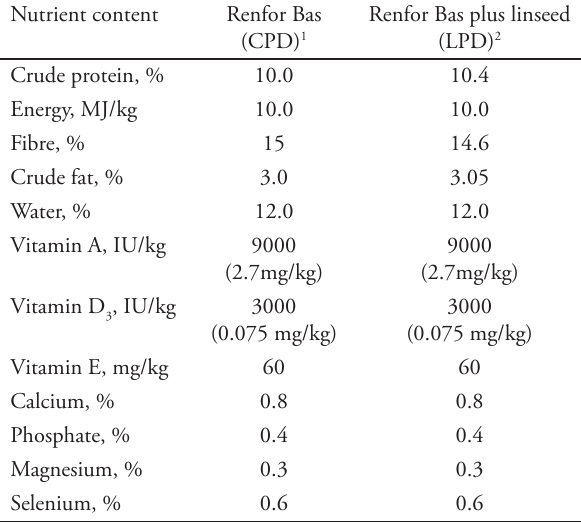
Table 1. Industrial nutrient analyses for the pelleted feeds (Renfor Bas and Renfor Bas enriched with crushed linseed) (Lant- männen,